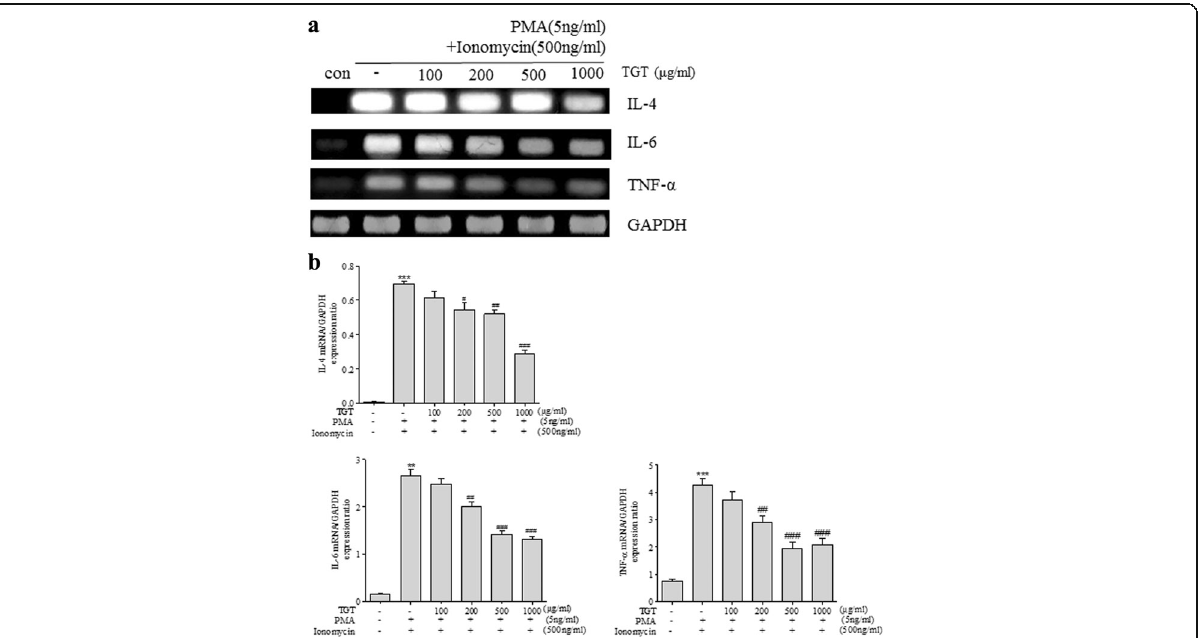
Fig. 1 Effect of TGT on expression of pro-inflammatory cytokines in PI stimulated HMC-1 cells. a PI-stimulated HMC-1 cells were treated with or without different doses of TGT for 24 h. Cytokine mRNA levels were measured by RT-PCR. b The density of each band was calculated with image processing program, Image J, and represented as bar graphs. *; compared to control. #; compared to stimulated cells. Control; HMC-1 with PI ( − ), Stimulation; HMC-1 with PI (+)